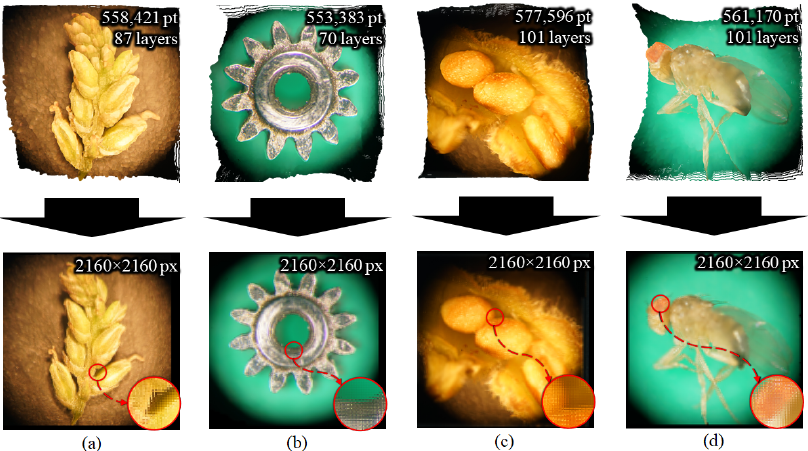
Figure 11. From the 3D point cloud models (top row), the new EIAs were generated through the DRC-based approach (second row) for ( a ) a grass seed, ( b ) a micro gear, ( c ) a balsam seed, and ( d ) a fruit